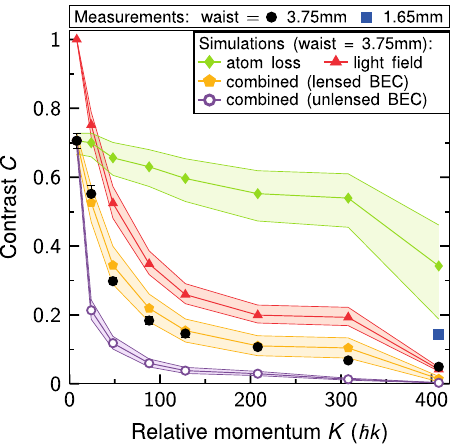
Fig. 3 Contrast analysis. Experimental (black circles) and theoretical contrast C of our twin-lattice interferometer in dependence of relative momentum K for a laser beam waist of 3.75 mm. We assume two effects triangles). Combining the simulation of both effects (orange pentagons)